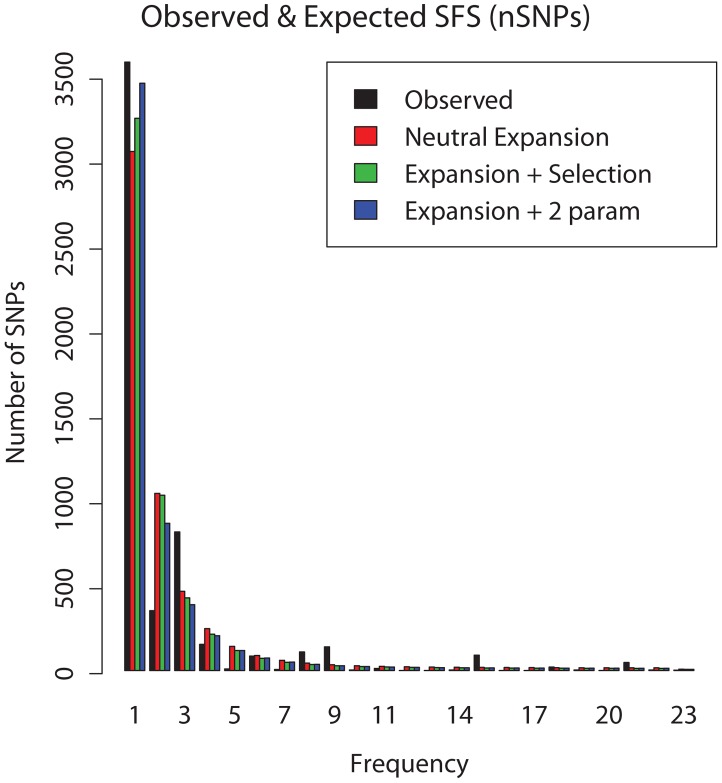
Expected site frequency spectrum (SFS) under various demographic and selective models.The folded SFS for non-synonymous SNPs: observed values are shown in black, and expected values under different models are shown in colors. Expected SFS for an instantaneous past expansion is shown in red, expansion plus a single selection coefficient at all sites is shown in green, and expansion plus two coefficients of selection (one negative and the other zero) is shown in blue. The improved fit of the two parameter selection model appears to be driven primarily by the large number of singleton SNPs in the observed data.